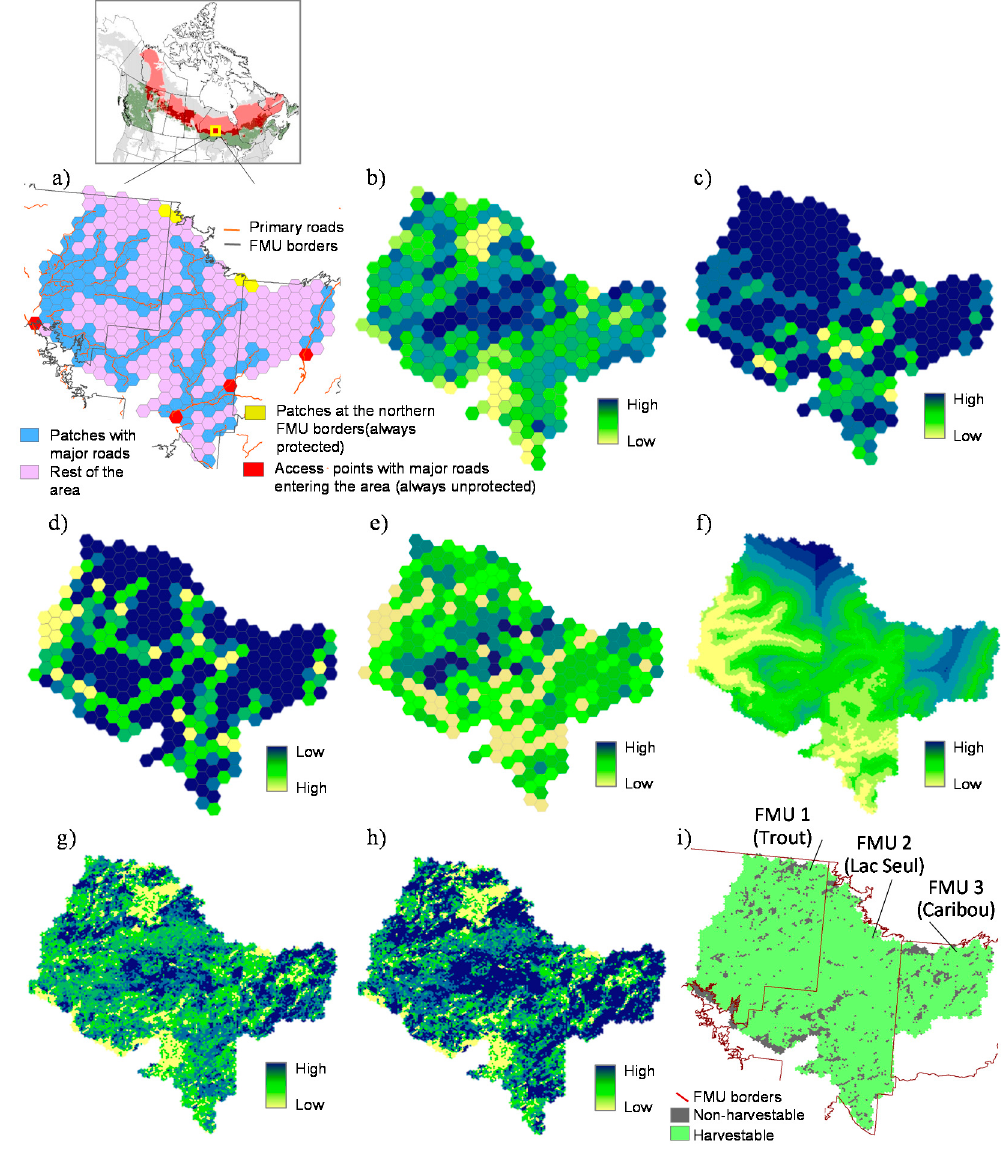
Figure 3. Model spatial inputs: ( a ) Patches j with permanent roads, access points with major roads entering the area and patches near the northern range border and the corners of adjacent regions that must remain protected to maintain habitat connectivity across the range; ( b ) habitat suitability map, β nit at t = 0; ( c ) intactness values; ( d ) permanent roads impact factor; ( e ) habitat amounts B j ; ( f ) timber hauling cost; ( g ) forest age at t = 0; ( h ) harvestable timber volume at t = 0; ( i ) harvestable area within FMUs 1–3.